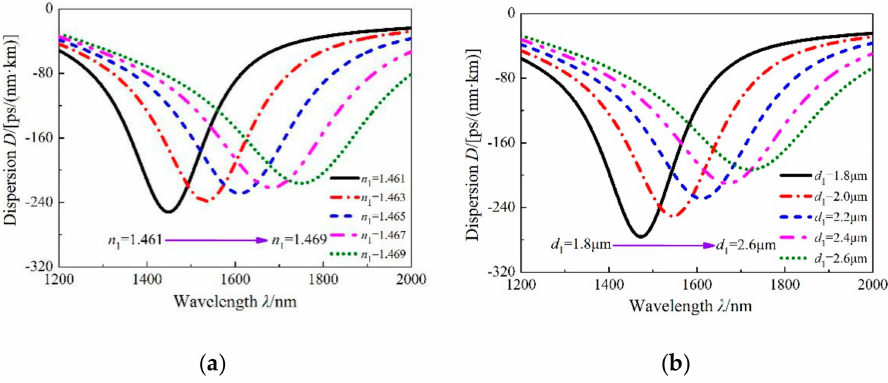
Figure 4. Variation of dispersion with n 1 ( a ) and d 1 ( b